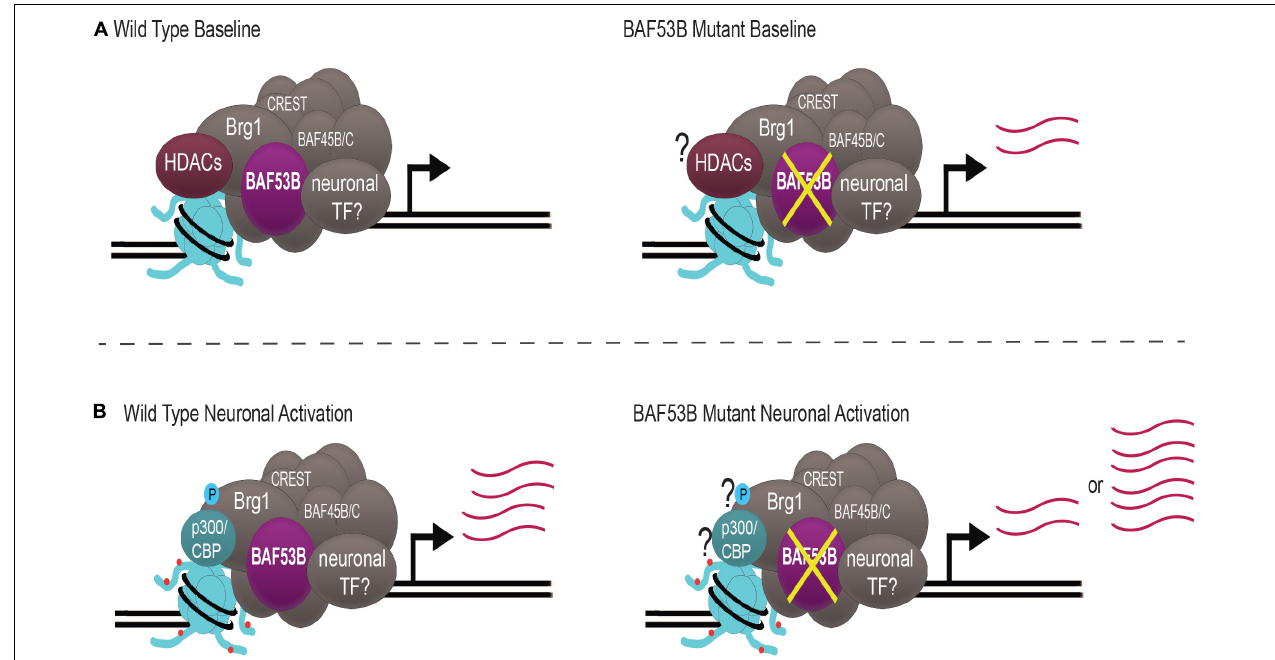
FIGURE 2 | nBAF regulates activity-induced gene expression through a dynamic system. (A) Under wild type baseline conditions, HDACs (maroon) are bound to nBAF (gray), which suppresses transcription of target genes. When BAF53B (purple) is mutated, there is atypical upregulation of activity-dependent genes. (B) With neuronal activation, Brg1 S1382 becomes phosphorylated (blue circle), p300/CBP (teal) replaces HDACs and H3K27ac (red circles) is increased, facilitating upregulation of activity-dependent genes. When BAF53B is mutated, there are some reports of normal activation of activity-regulated genes and some reports of hyper-induction of activity-regulated genes. Question marks represent key contributors whose status is unknown in BAF53B mutants. Transcript abundance is depicted by pink lines. nBAF specific subunits BAF53B, BAF45B/C and CREST are